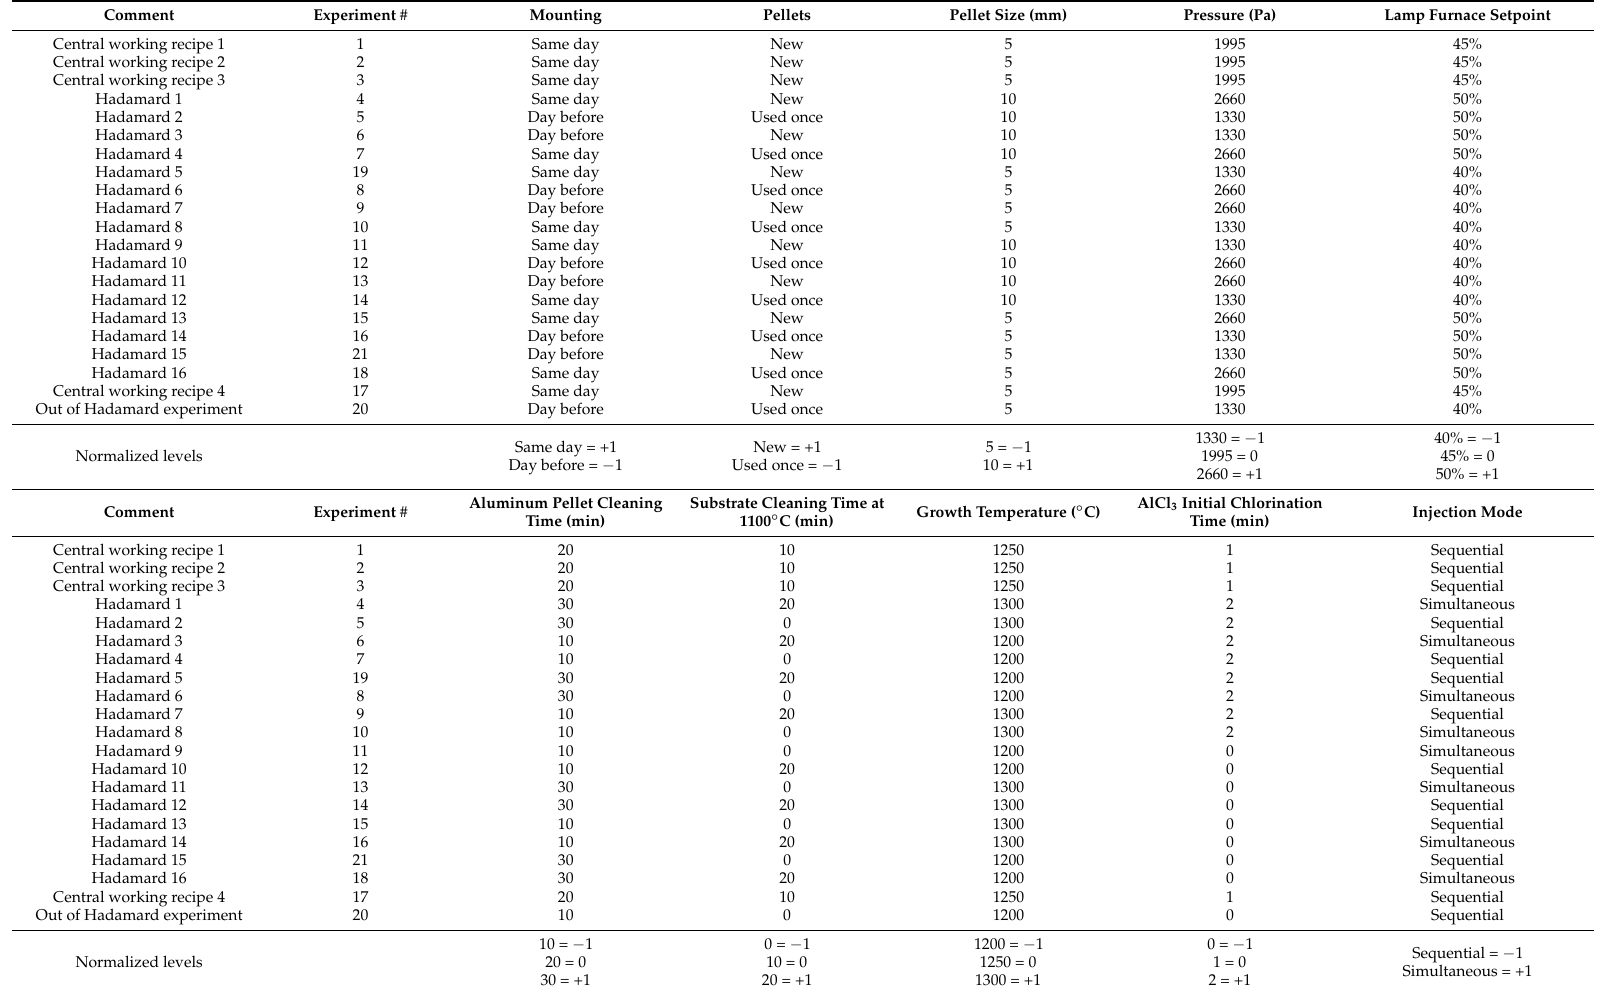
Table 1. Experimental campaign designed by the screening method following Hadamard matrix of order 16. 1 sccm = 7.44 × 10 − 7 mol · s − 1 . The chronological order of experiments may not follow the order of Hadamard